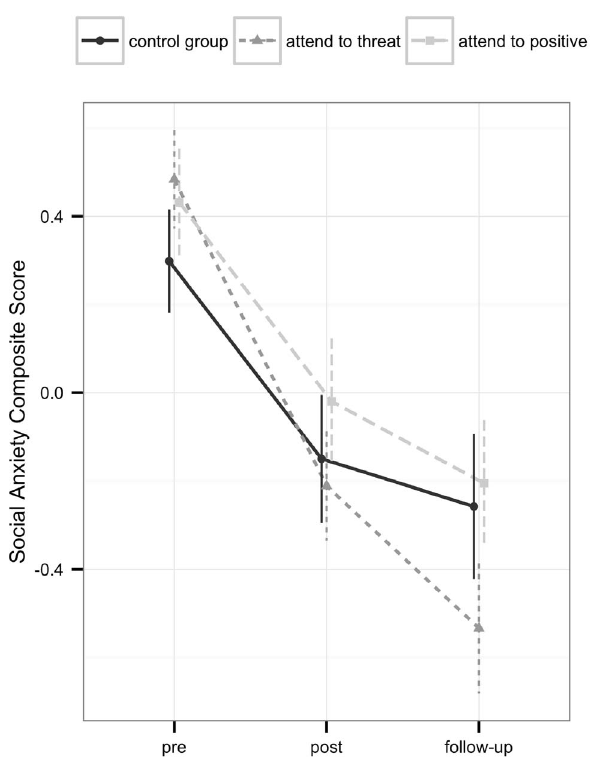
Figure 2. Change in social anxiety from pre- to follow-up-